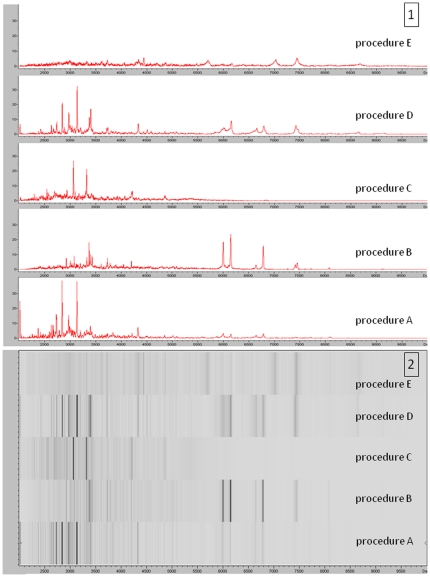
MALDI TOF MS spectra obtained with the 5 extraction procedures.(A) Gel view of the spectra of the Aspergillus fumigatus AFUM001strain obtained with the different extraction procedures. (B) List view of the spectra of the AFUM001obtained with the different extraction procedures. These procedures are detailed in the Material and Method section. The peaks obtained with procedure B, C and E were fewer and of lower intensity than those obtained with procedures A.